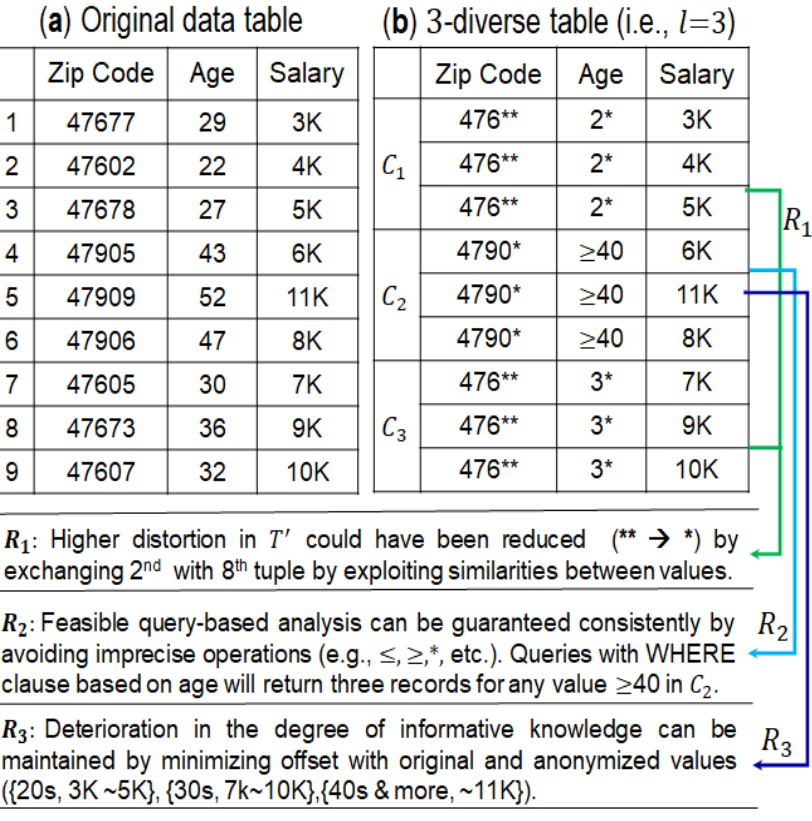
Figure 6. Overview of the k -anonymity model used for the privacy preservation of the individual.